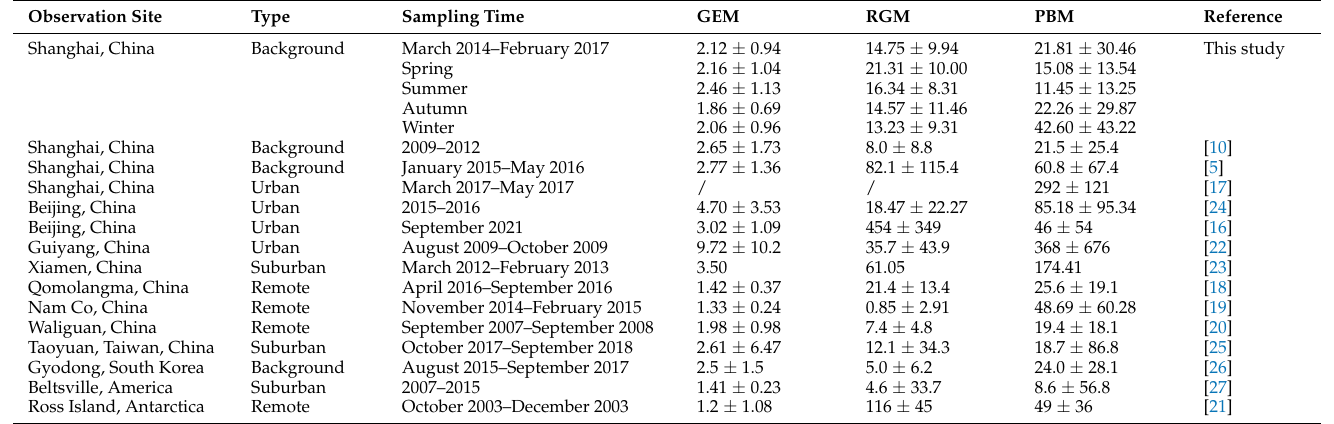
Table 1. Concentrations of GEM (ng/m 3 ), RGM (pg/m 3 ) and PBM (pg/m 3 ) at Chongming Island, Shanghai and other